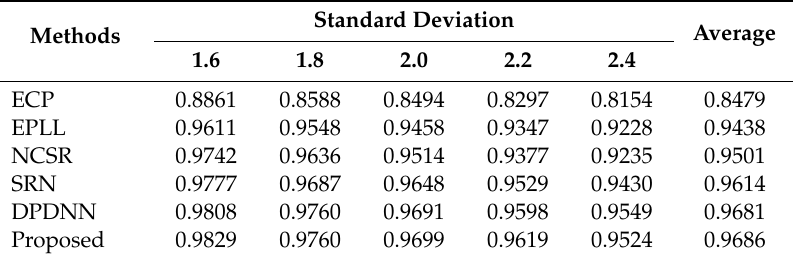
Table 6. The SSIM results of the deblurred images in the GoPro